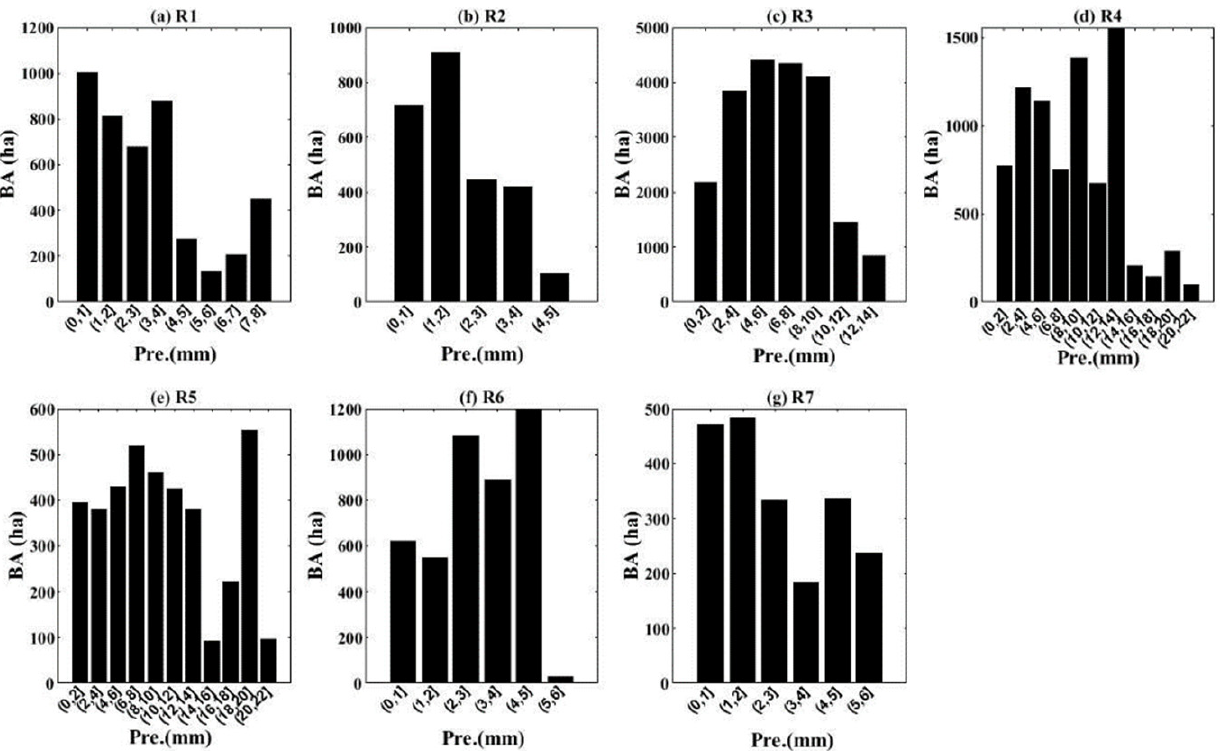
Figure 19. The histogram of BA with different precipitation intervals for ( a – g ) representing R1–R7,